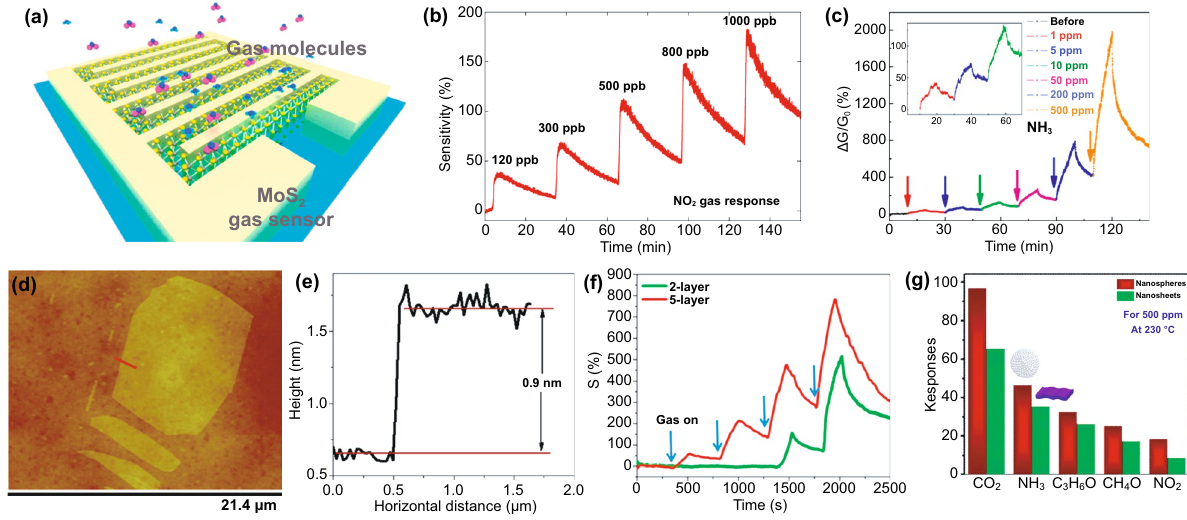
Fig. 12 a 3D schematic image of the MoS 2 gas sensor device under gas molecules. b The transient NO 2 gas response of the MoS 2 device from 120 to 1000 ppb at RT. Adapted from Ref. [193]. Copyright 2015, American Chemical Society. c Real-time conductance change in MoS 2 FETs with time after exposure to NH 3 under different concentrations, adapted with permission from Ref. [194]. Copyright 2014, American Chemical Society. d AFM image and e corresponding AFM height profile of single-layer MoS 2 sheet deposited on 300 nm SiO 2 /Si substrate using the micromechanical cleavage method. f Comparative two- and five-layer MoS 2 cyclic sensing performances with NO 2 (for 100, 200, 500, 1000 ppm). Reprinted from Ref. [176]. Copyright 2013, American Chemical Society. g Selectivity of MoS 2 nanostructures for different gases, reproduced from Ref. [188]. Copyright 2018